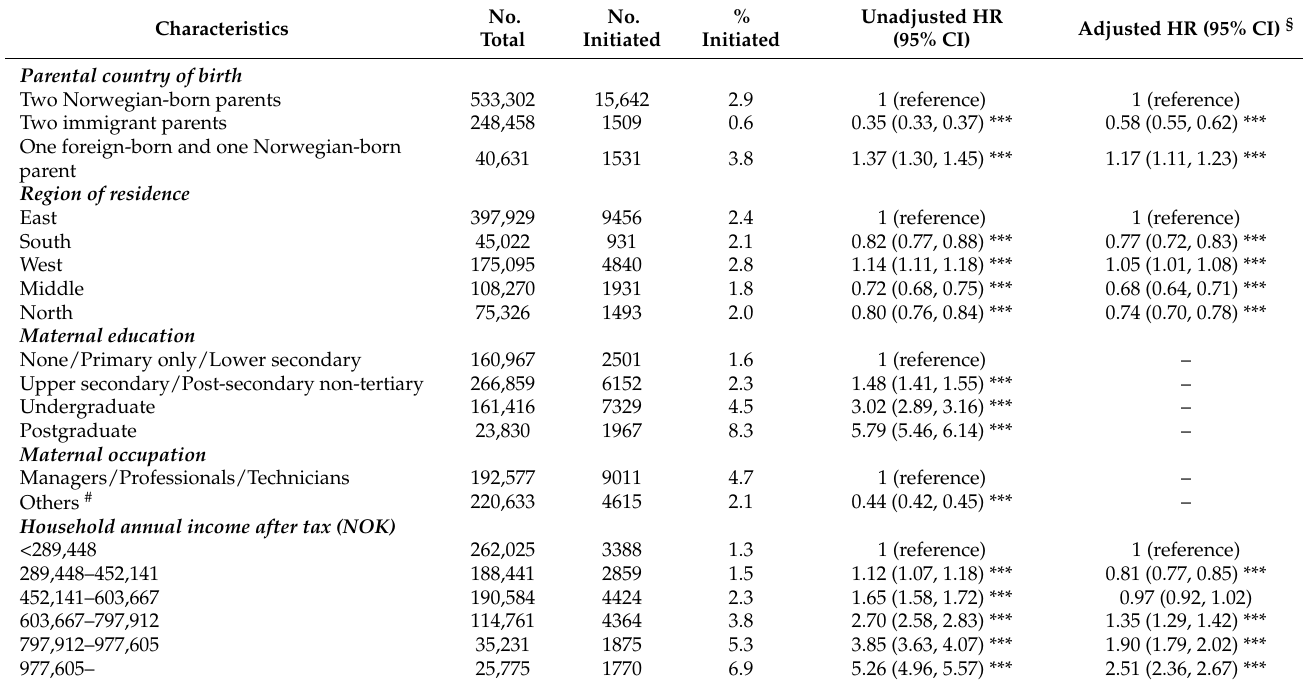
§ Estimates adjusted for all variables in the table (N = 839,251) except for maternal education level and maternal occupation, which were not included due to a high proportion of missing values. # Others refers to clerical support workers, service and sales workers, skilled agricultural, forestry and fishery workers, craft and related trades workers, plant and machine operators and assemblers and elementary occupations. *** p < 0.0001. Abbreviations: HR: hazard ratios; CI: confidence interval.